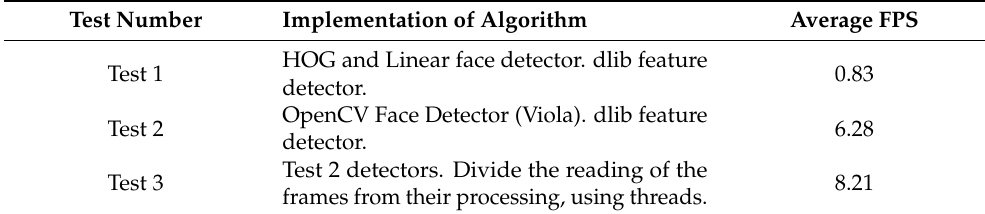
Table 5. Performance tests for different implementations of dlib.